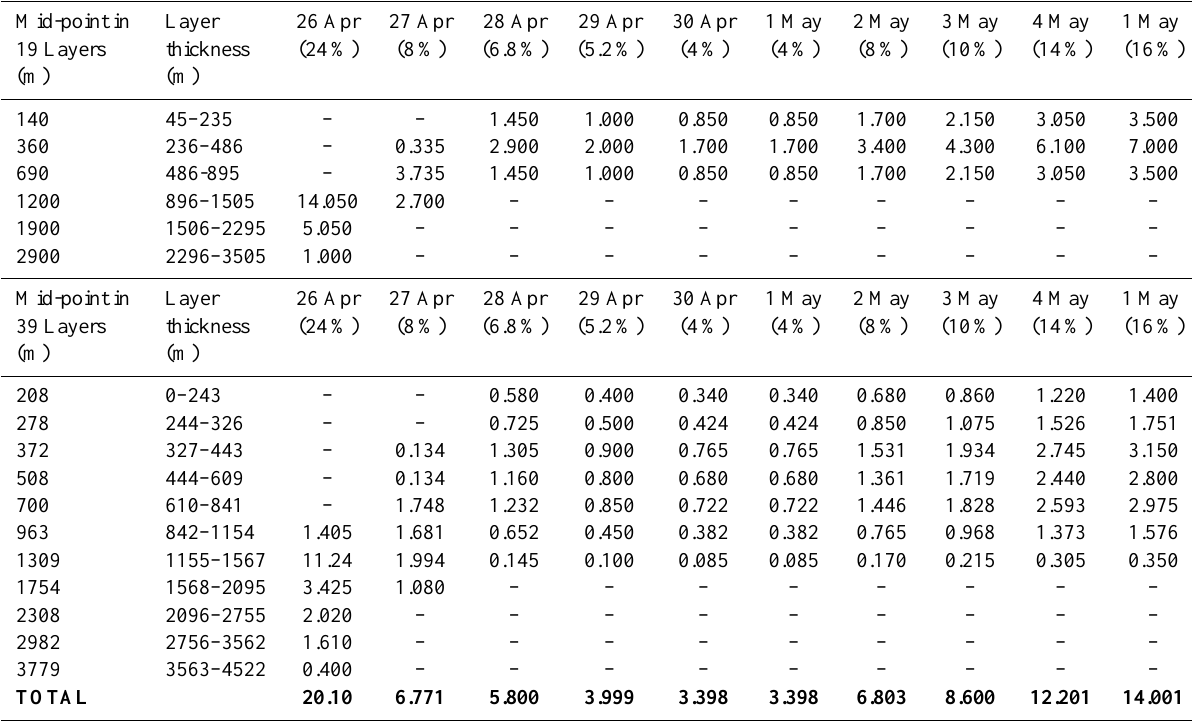
Table 1. Daily emissions of 137 Cs inPBq after the Chernobyl accident in 1986 (according to Brandt et al., 2002) and relative vertical distribution in the model for 19 and 39 layers.